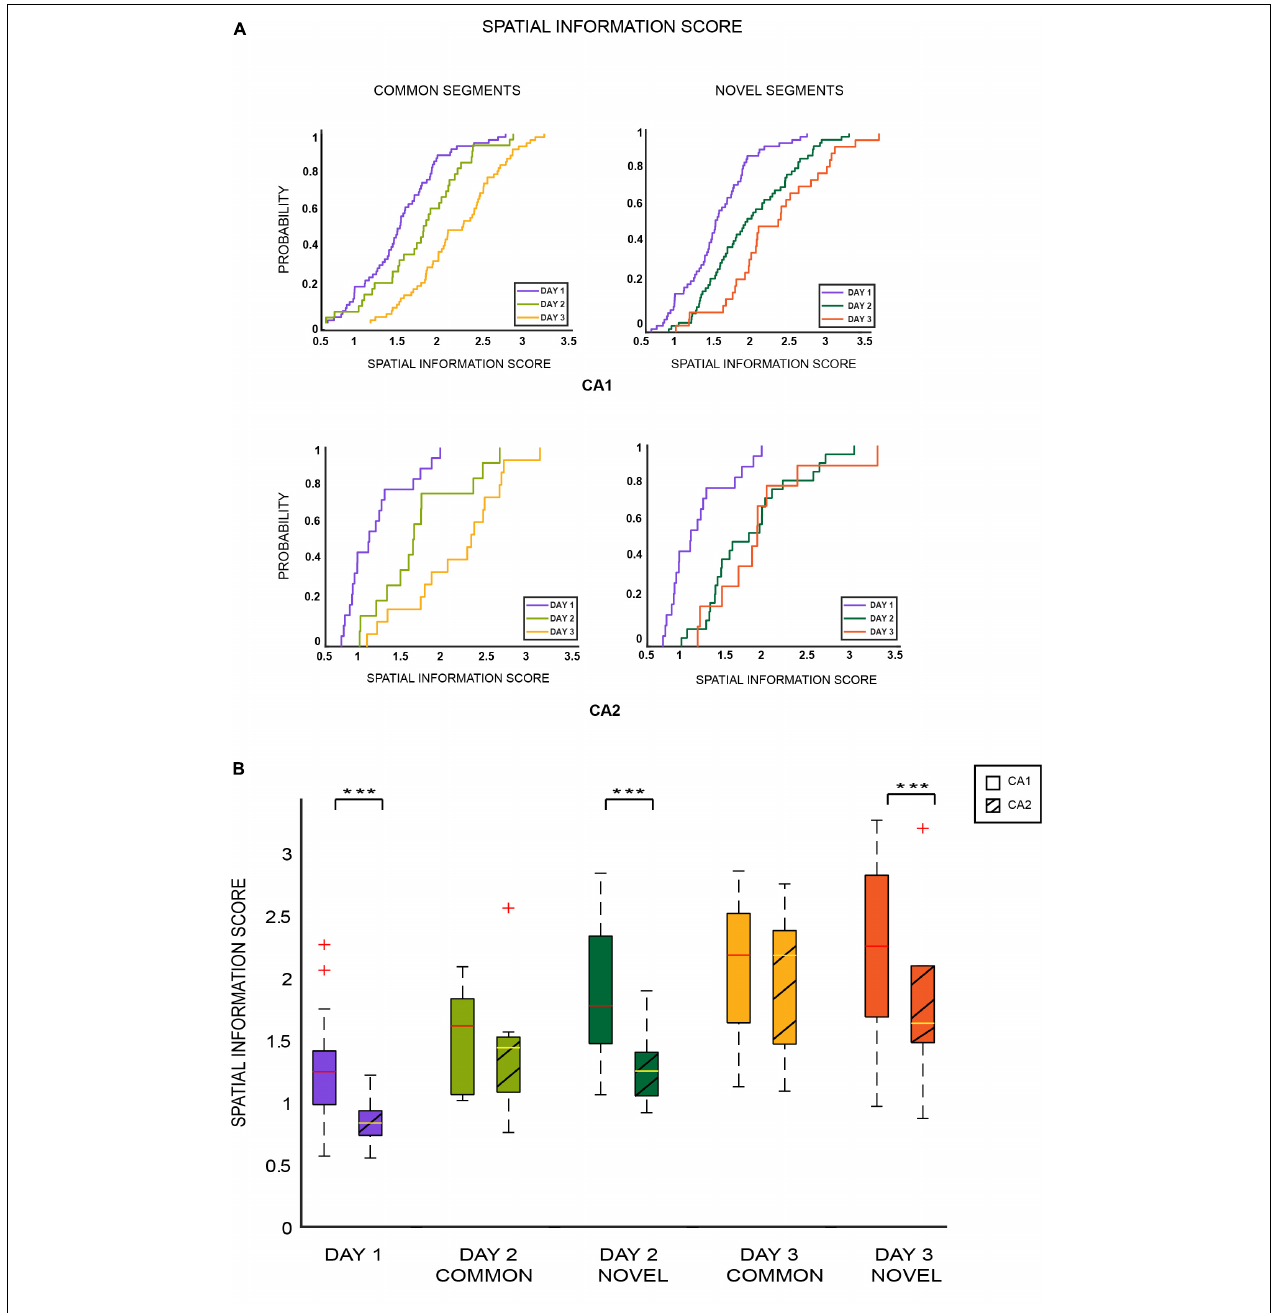
FIGURE 3 | (A) Cumulative distribution plots (EDCFs) for CA1 and CA2 place cells across days for common (left column) and novel segments (right column). For both sets of comparisons, spatial information scores for both ensembles increased over days, as overall familiarity of the environment increased (*** indicates p < 0.0005) (two-sample Kolmogorov–Smirnov test: common segments: CA1 cells: p < 0.01, CA2 cells: p < 0.02; novel segments: CA1 cells: p < 0.001, CA2 cells: p < 0.005 except for RUN2new/RUN3new p = 0.77). (B) Spatial information scores were calculated and plotted as boxplots for CA1 and CA2 cells separately and compared across days for different segments of the tracks with respect to familiarity and novelty. It was observed that spatial information scores were lower for CA2 place cells that coded for novel areas of the track (day 1, day 2 novel, and day 3 novel) in comparison to CA1 place cells coding for the same novel space. However, information scores for both ensembles remained similar and comparable for familiar areas (day 2 common and day 3 common) [Mann–Whitney test: novel segments (days 1, 2, and 3): CA1 vs. CA2: p = 0.00004; common segments (days 2 and 3): CA1 vs. CA2: p = 0.2124]. This indicates poor spatial coding in CA2 place cells for novelty but not familiarity in comparison to